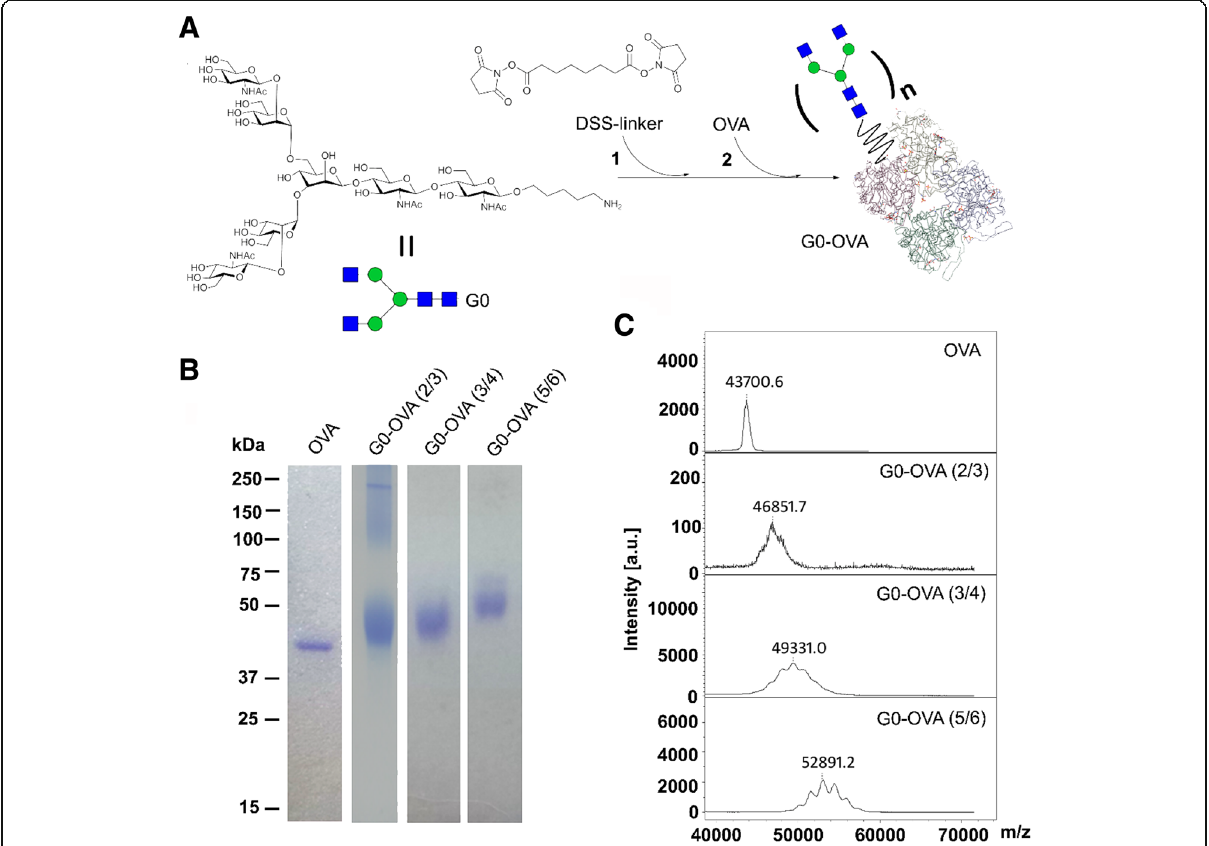
Fig. 2 a Synthesis of G0-OVA neoglycoconjugates ( n = valency). b SDS-PAGE gel electrophoresis of OVA and G0-OVA neoglycoproteins containing different valencies of N-glycan G0. c MALDI-TOF mass spectra of OVA and G0-OVA neoglycoproteins containing different valencies of N-glycan